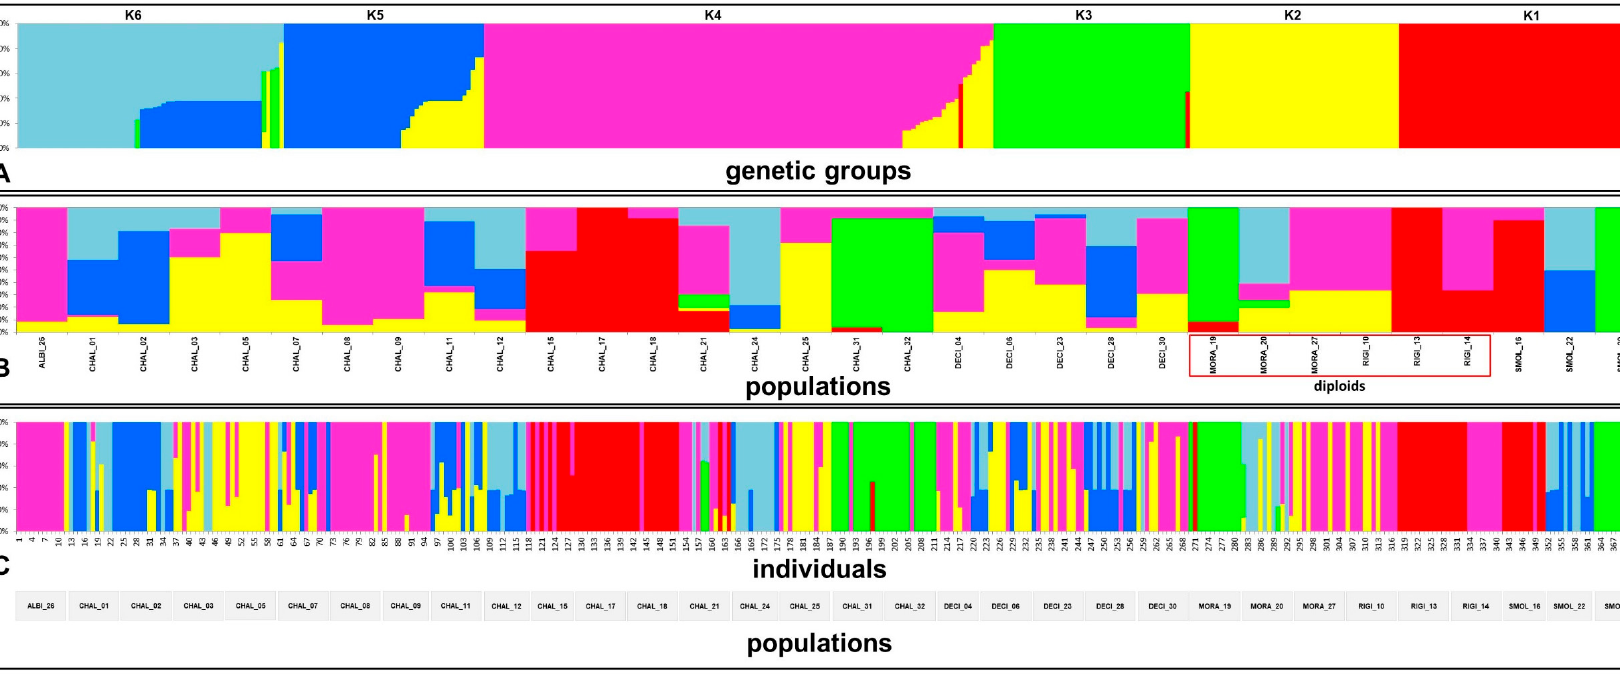
Figure 2. Bayesian clustering of AFLP-data from STRUCTURE, showing: ( A ) Relative proportion of each of the six genetic groups (1–6) across the 32 populations (width of the colored band); ( B ) proportion of the population membership to each of the six genetic groups; populations including more than one group (color) are admixed; diploid populations are indicated (red box); ( C ) proportion of the individual membership to the six genetic groups across the 32 populations (374 individuals); individuals including more than one group (color) are admixed.